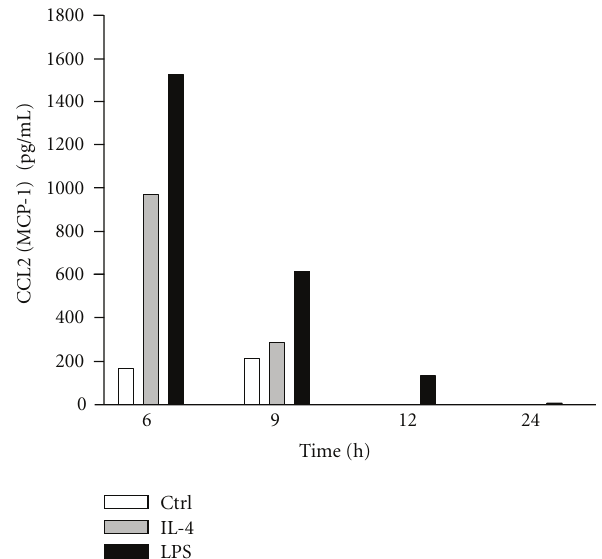
Figure 3: IL-4 increases CCL2 protein expression in the exudates. Air pouches was created as described in Materials and Methods and 1ml of the bu ff er (Ctrl), LPS (1 μ g/ml), or IL-4 (250ng/ml) were administered into the pouch. Exudates were harvested after 6, 9, 12 and 24 hours, pooled ( n ≥ 7) and then CCL2 production was measured by ELISA.